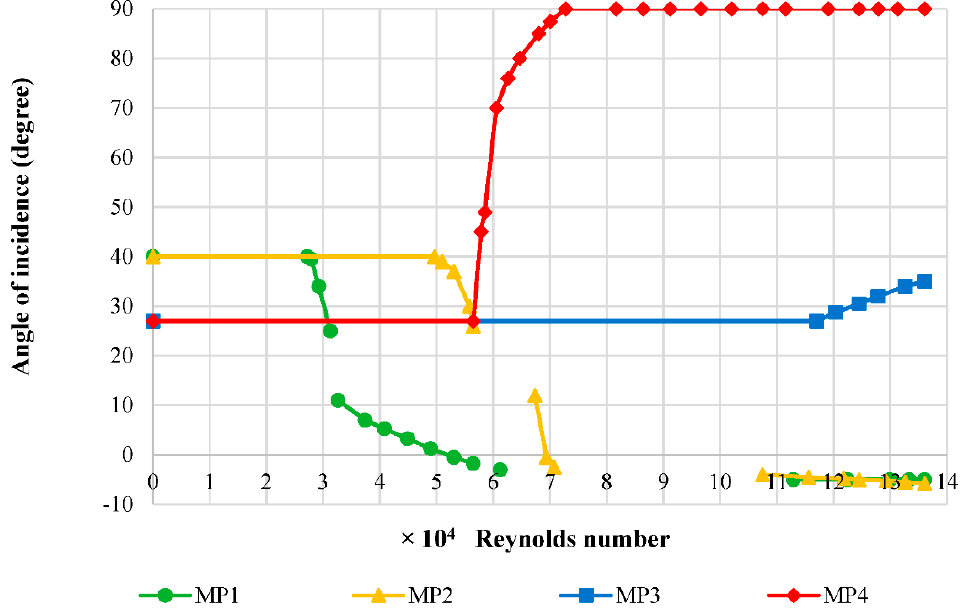
Figure 9. Effect of Pivot point location on NACA 6412.